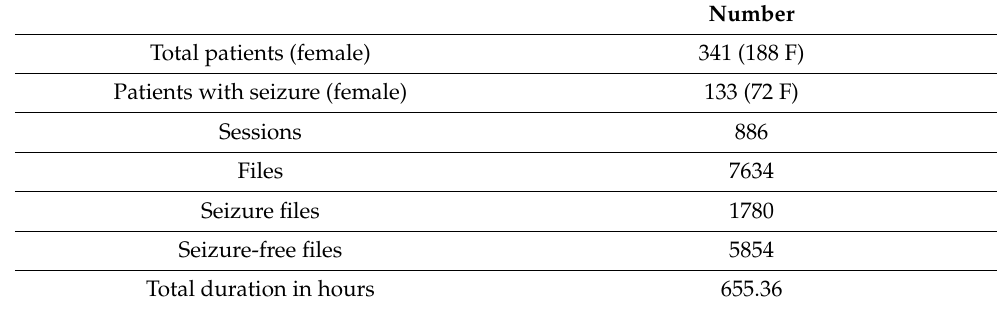
Table 1. Overview of the subset of the TUSZ EEG corpus used in this study for seizure detection.